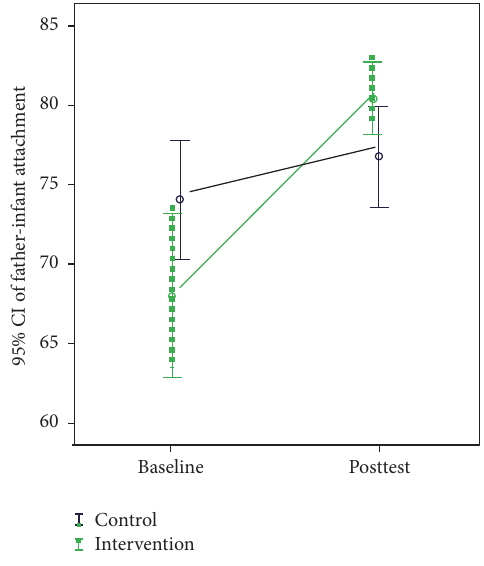
Figure2:Changesinfather-infantattachmentscoresatbaselineand